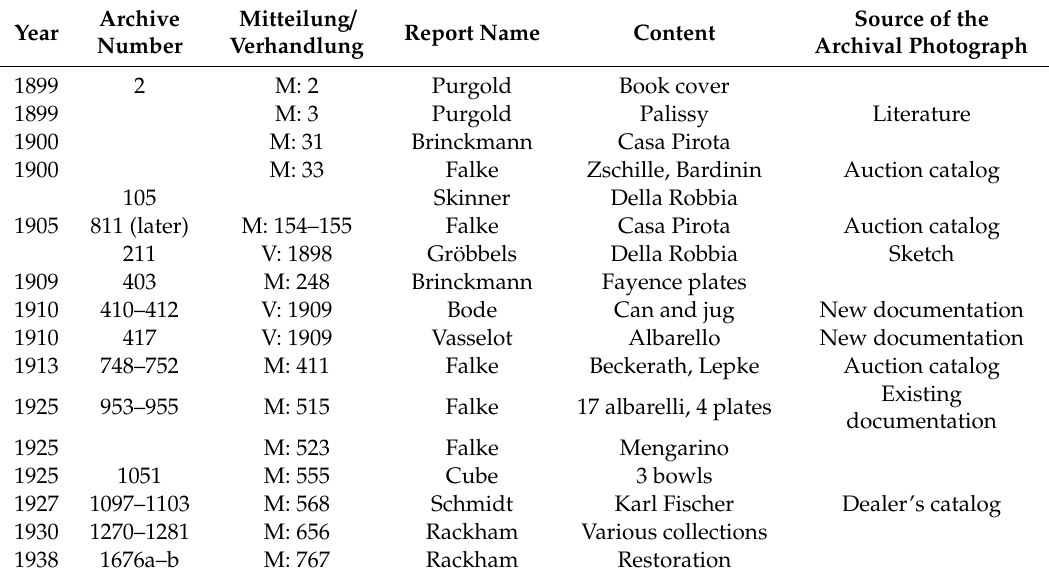
Table 1. Overview of maiolica cases in the Association’s